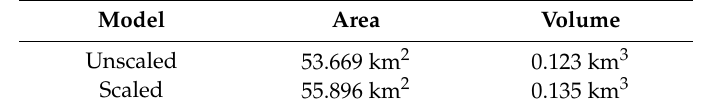
Table 3. RMSEs for area and volume of Lake Namco.